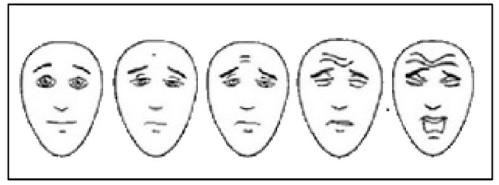
The Faces Scale for Trait and State Mathematics